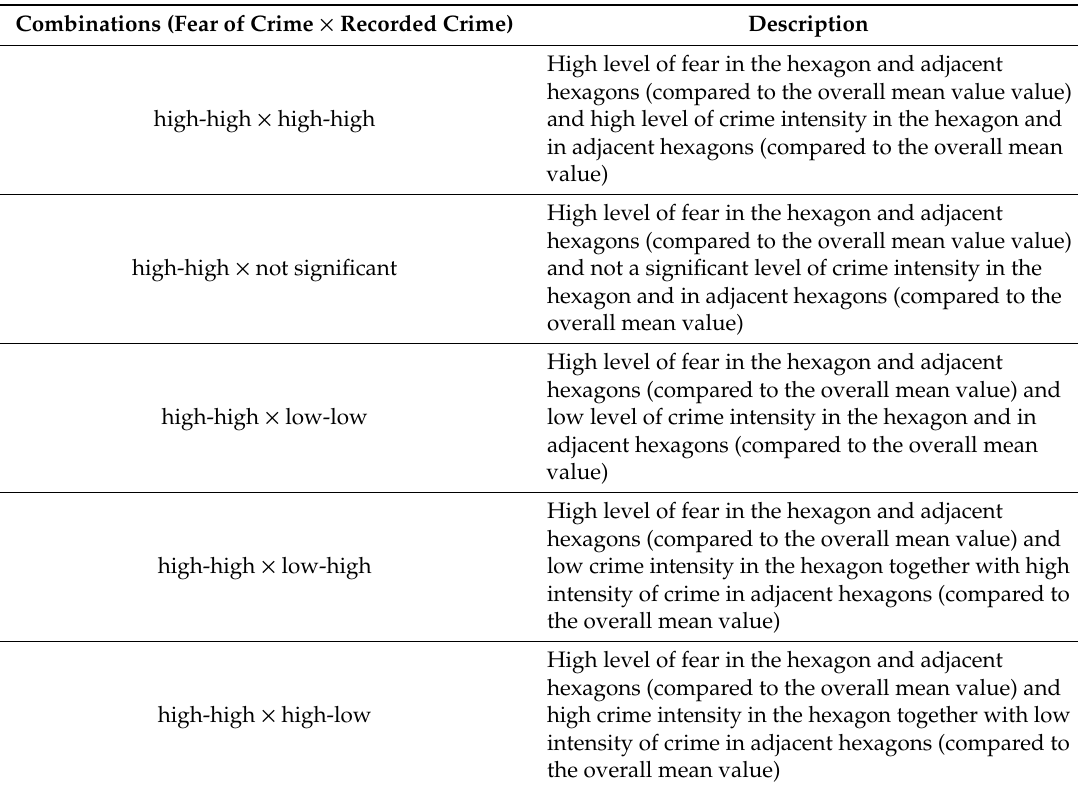
Table 3. The description of classes used in a combined cluster